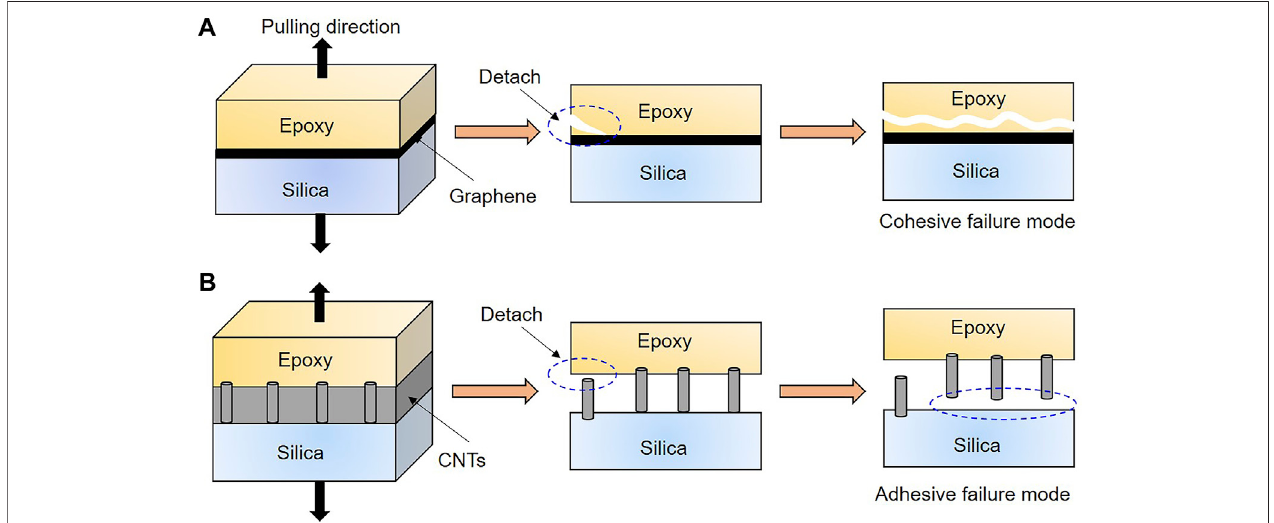
FIGURE 7 | Mechanism of interface failure for the sandwiched structures with (A) graphene coating. The debonding initiates from the edge of epoxy close to the interface and propagates into the inner ofepoxy. The graphene-coated GFR epoxy exhibitsacohesivefailuremode. (B) CNTs coating. Although the debonding initiates betweenepoxy and CNTs, the interlocking between epoxy and CNTs preventsthe furthermotion ofpolymer chains, resulting inthat failure which occursat theinterface between silica and CNTs. The CNT-coated GFR epoxy displays an adhesive failure mode.